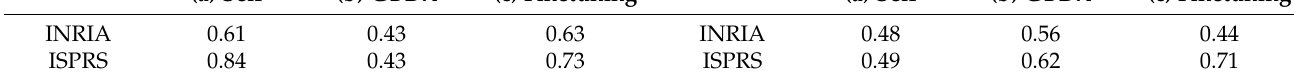
Table 5. Impact of transfer learning (RQ3), i.e., pretraining and fine-tuning. DICE scores of SegNet and Mask R-CNN for the test sets of INRIA/ISPRS when trained on (a) INRIA/ISPRS, (b) GBDX, and (c) pretrained on GBDX and fine-tuned on INRIA/ISPRS. SegNet Mask R-CNN